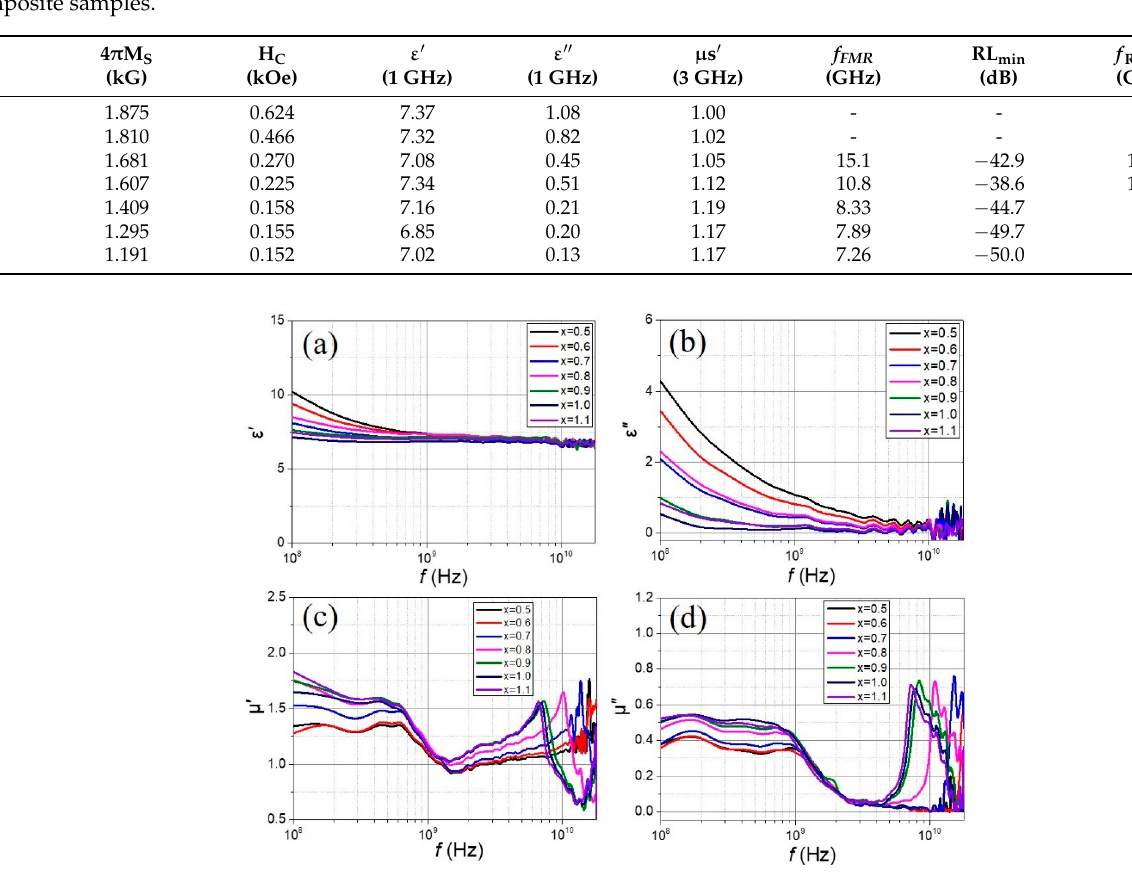
Figure 6. ( a – d ) Real and imaginary parts of permittivity ( ε′ and ε″ ) and permeability ( μ′ and μ″